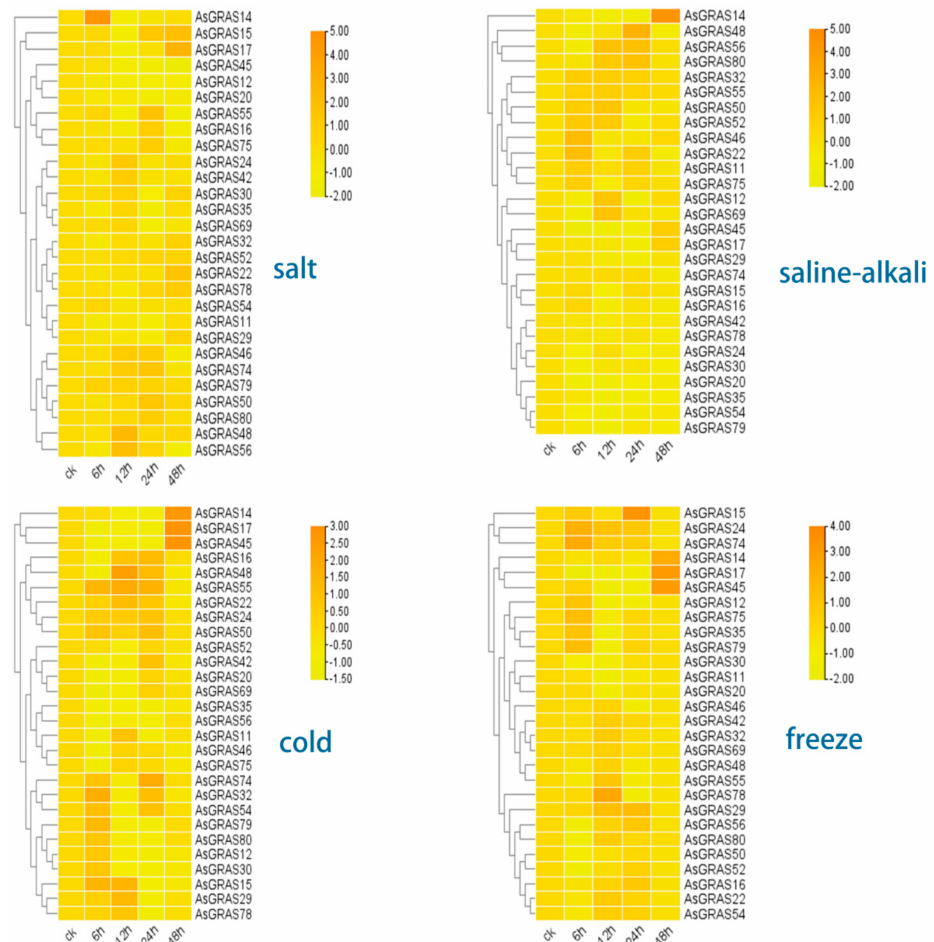
Figure 6. The expression patterns of GRAS genes under 4 stresses (salt, saline–alkali, cold, and freezing stress